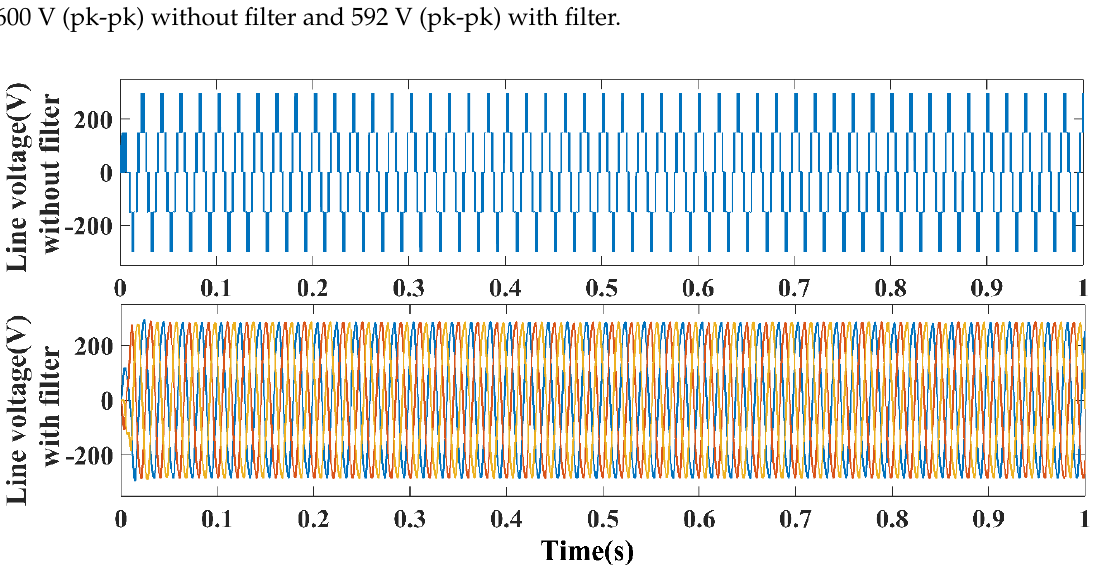
Figure 8. Line voltage of NPC inverter with and without filter .